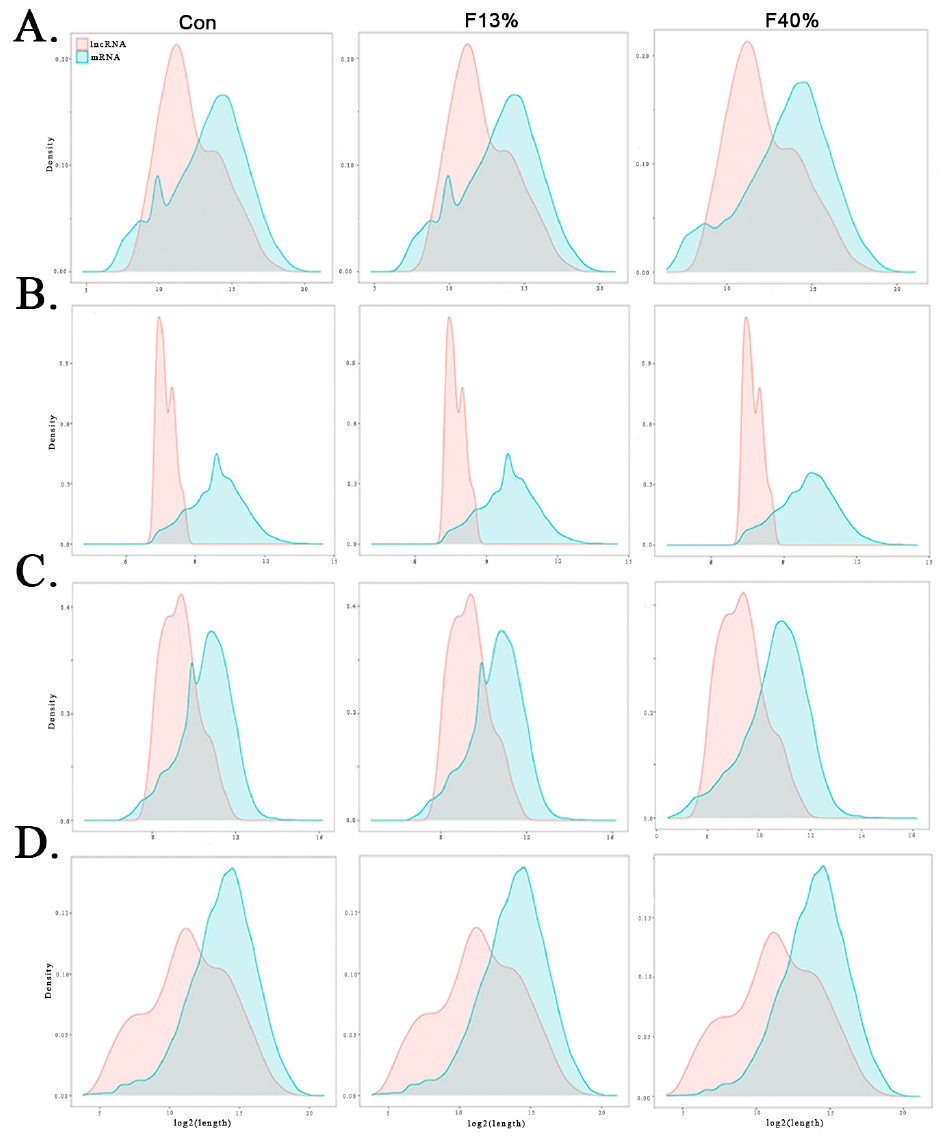
Figure 3. Structures and expression of long non-coding RNAs (lncRNAs) and mRNAs. ( A ) Full- length distribution of lncRNAs and mRNAs. ( B ) Number of exons per transcript. ( C ) Open reading frame size distribution of lncRNAs and mRNAs. ( D ) Number of introns per transcript.